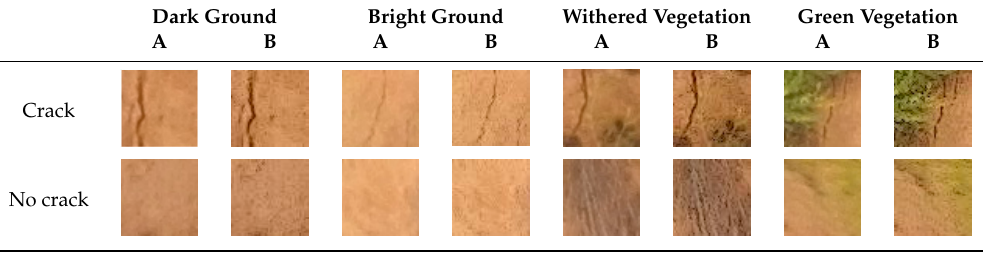
Table 10. Schematic diagram of the effect of the image after Laplace sharpening and original image.